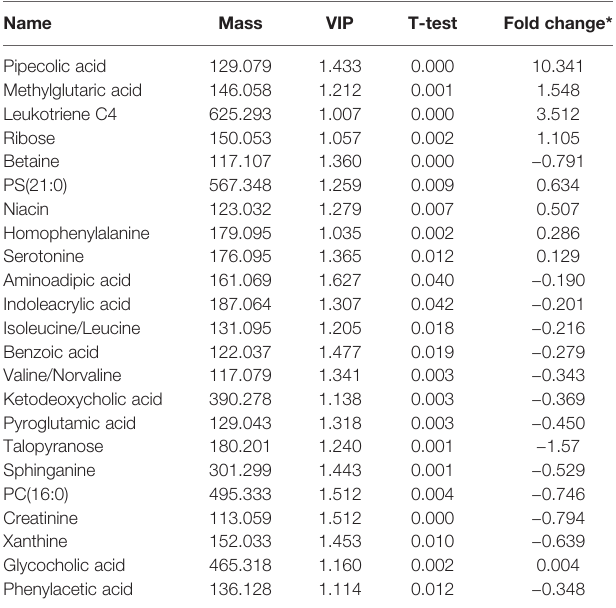
TABLE 1 | Differential carbon ion irradiaton induced metabolites between 2 and 0 Gy controls in the Learning